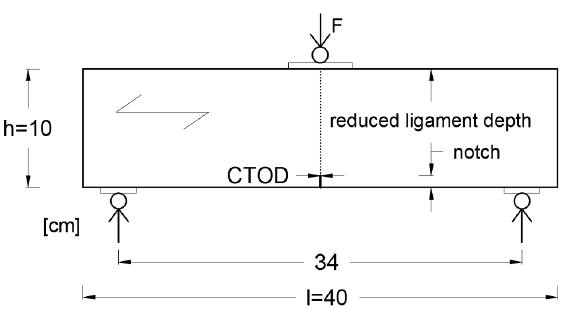
Figure 3. Sketch for shear failure [9].